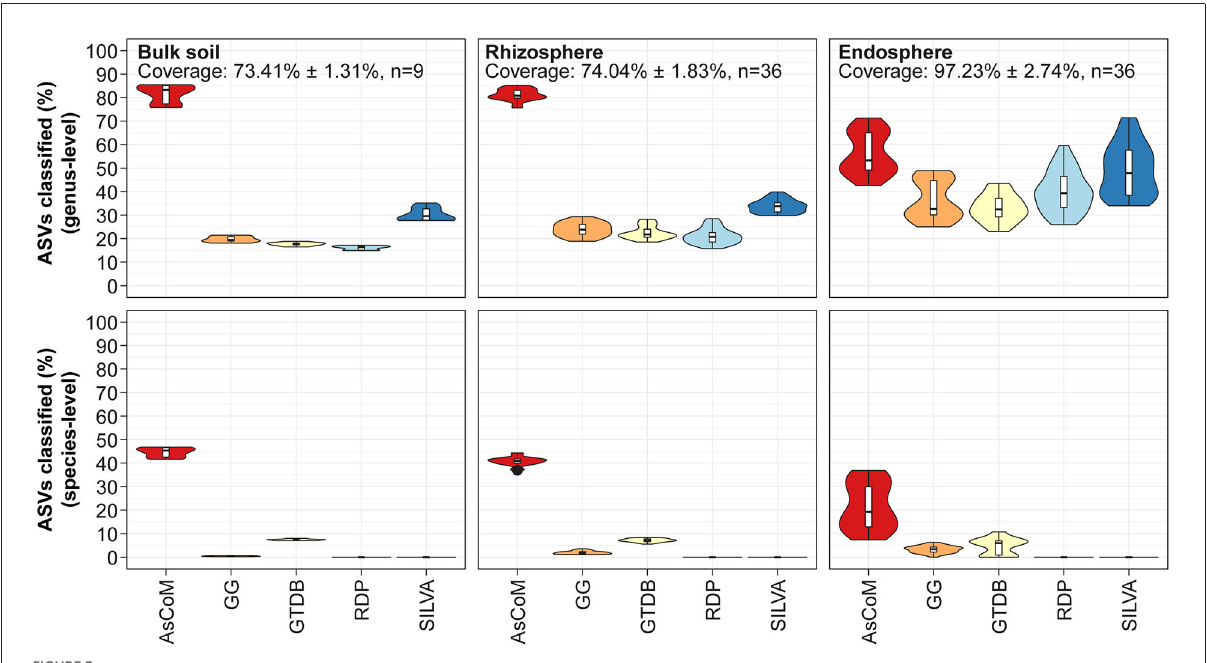
FIGURE3 Database evaluation based on classification of short-read amplicon data. The V5–V7 amplicon data used in Figure 2 was classified using the SINTAX-classifier with AsCoM, GreenGenes 16S 13.5 (GG) (Desantis et al., 2006), GTDB release 89 (Parks et al., 2020), RDP 16S v16 (Cole et al., 2014), and SILVA 138.1 SSURef NR99 (Quast et al., 2013). The ASVs were filtered based on their relative abundance (only ASVs with ≥ 0.01% relative abundance were kept) before the analyses. Coverage shows how much of the accumulated read abundance these abundant ASVs accounted for (mean ± standard deviation, number of